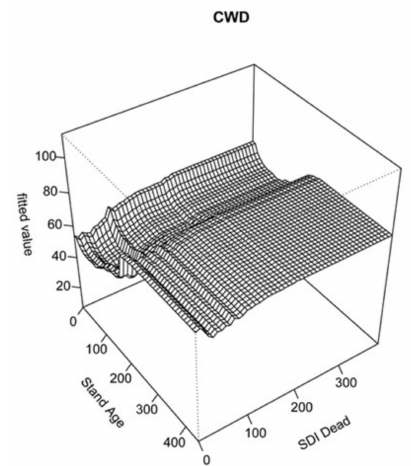
Figure 9. Three-dimensional interaction plot showing the relationship between the top two predictors from random forest model stand age and stand density index dead (SDI_dead) on CWD loading. The vertical axis is the fitted values for CWD loading.